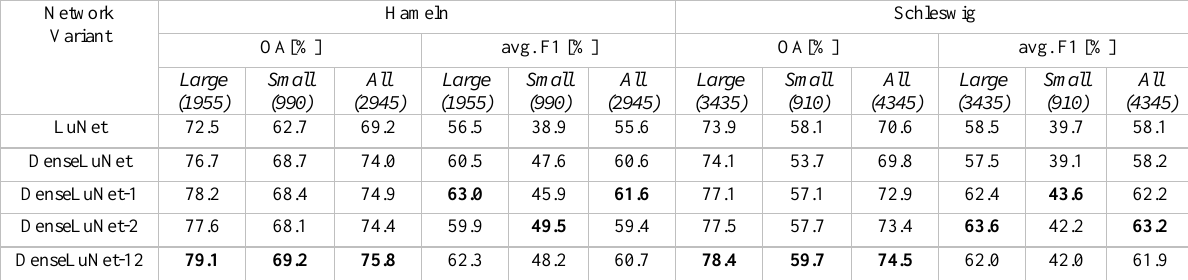
Table 2. Results of land use classification represented separately for large, small and all polygons (cf. Table 1). The results are provided for all the network variants on Hameln and Schleswig dataset. The number of polygons in each set is given in